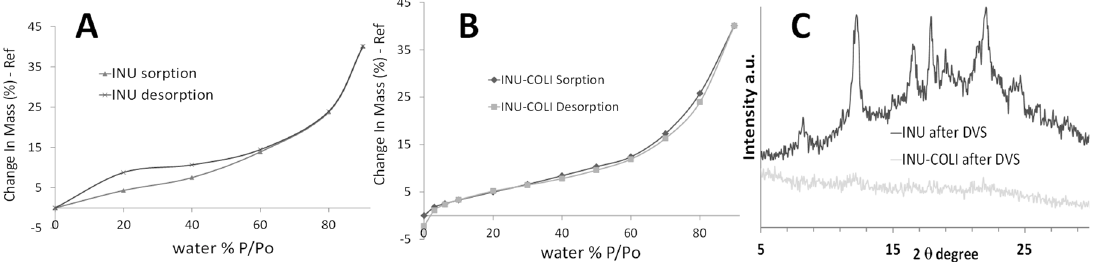
Figure A2. Water sorption–desorption isotherms obtained by DVS of ( A ) INU spray-dried powder and ( B ) INU-COLI spray-dried powder. ( C ) XRD patterns of INU and INU-COLI after one water